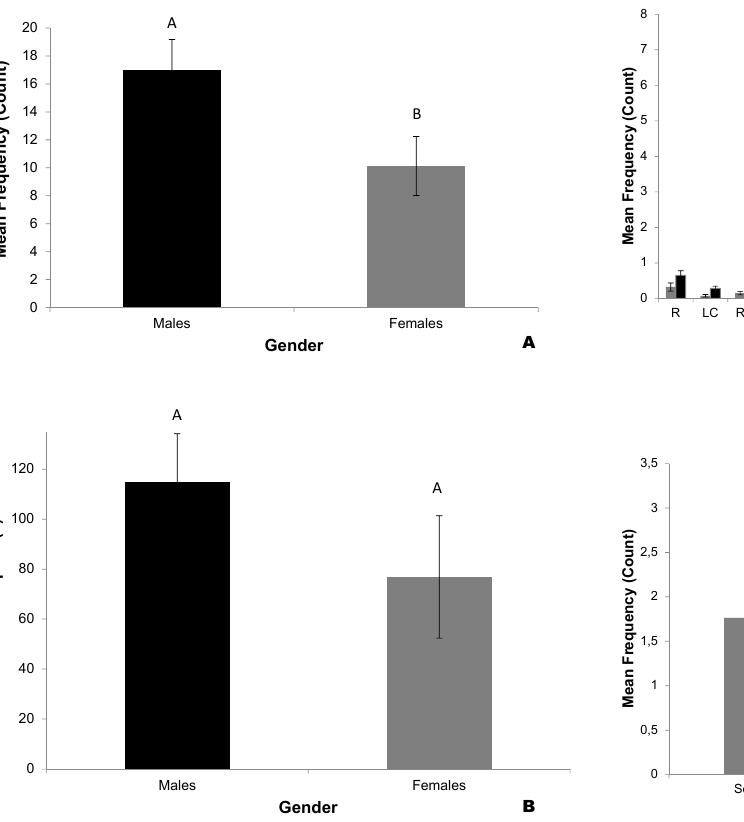
Figure 2. Grooming frequency and grooming time, with standard error bars, of males and females in 30-min isolation observations (N=142 total; N=89 males; N=53 females). A. Mean frequency of grooms by males and females (z=-10.3, p<0.001). B. Mean time spent grooming by males and females (z=1.95, p=0.0507). Note: Similar letters indicate no statistical significance (p>0.05) and different letters indicate a statistical significance